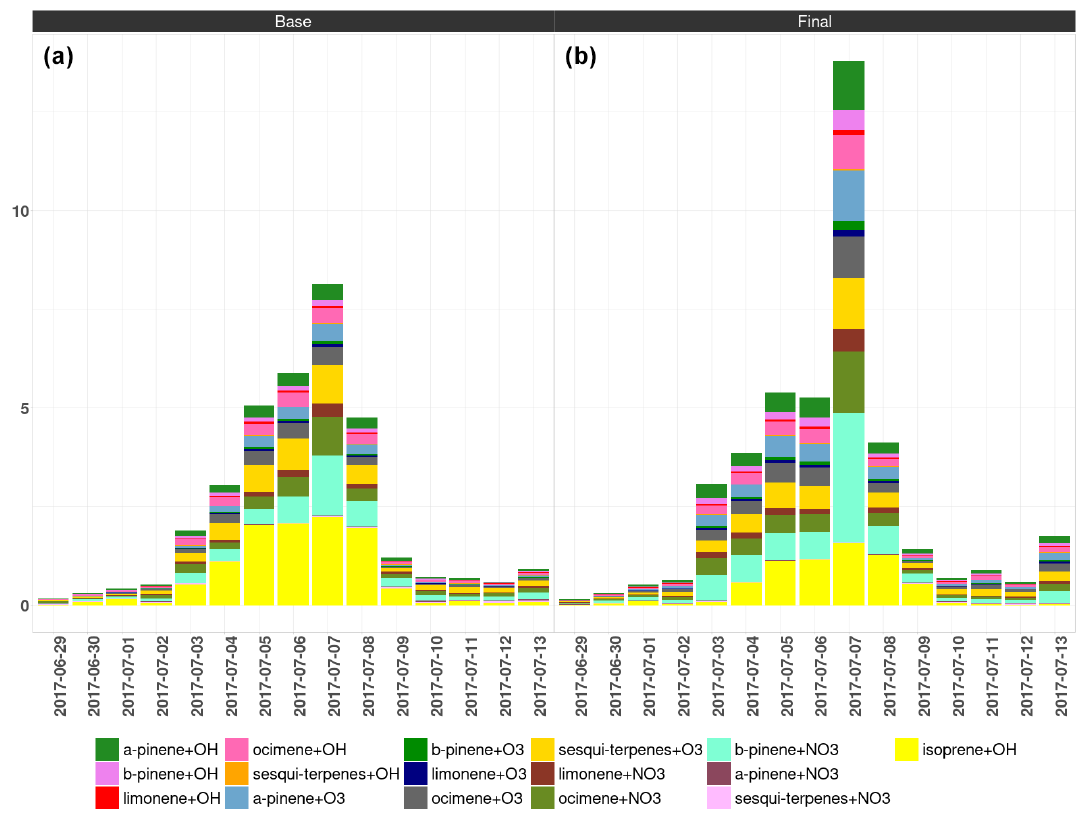
Figure 12. Daily averaged concentrations of BSOA per precursor and per oxidant (in µgm − 3 ). The colors for each reaction are defined in the legend. The base case simulation results are shown in (a) , while the final case results are shown in (b)